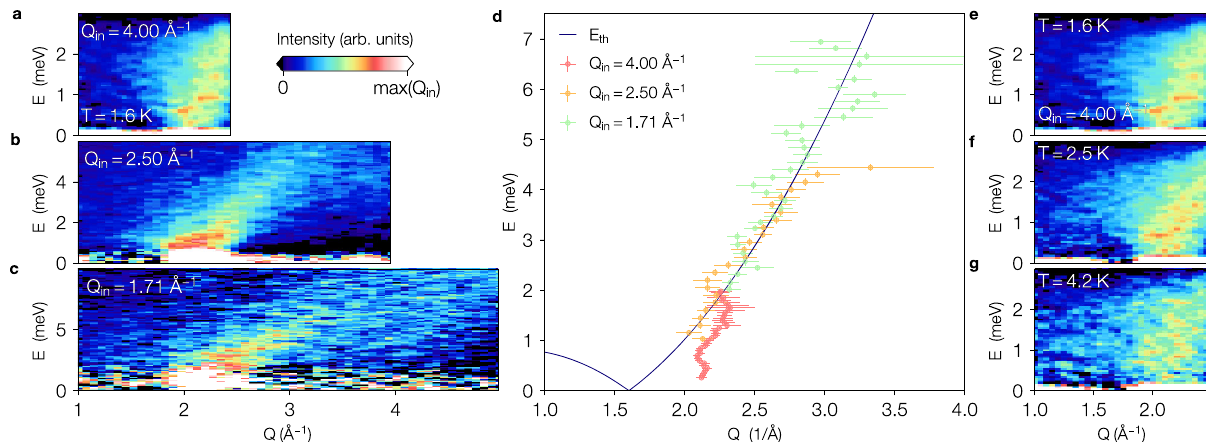
Fig. 4 Energy and temperature dependence of the inelastic scattering branch. Left panels: Inelastic scattering from con fi ned 4 He at various incident wave vectors covering different Q − E ranges with different resolutions. The plots correspond to incident wavevectors of: a 4.00 Å − 1 , b 2.50 Å − 1 , and c 1.71 Å − 1 . The Q scales are the same for all three values, but the energy ranges are different. d The peak excitation energies obtained by fi tting a Gaussian in energy to the inelastic scattering in a – c with the Q and E uncertainties determined in the fi t shown as standard error bars. The solid line is the best fi t to the threshold energy of a purely 1D quantum liquid of hard spheres. The fi t was obtained by fi xing k F = 0.8 Å − 1 , as extracted from the S ( Q , 0) measurement, and yielded K ¼ 1 : 18 þ 0 : 38 (cid:2) . Right Panels: Inelastic scattering from con fi ned helium at various temperatures above and below the bulk super fl uid transition. 0 : 20 The measurements have fi xed Q in = 4.00 Å − 1 and temperatures of: e 1.6 K, f 2.5 K, and g 4.2 K. The scattering intensity decreases slightly with increasing temperature but remains large even at the highest temperature